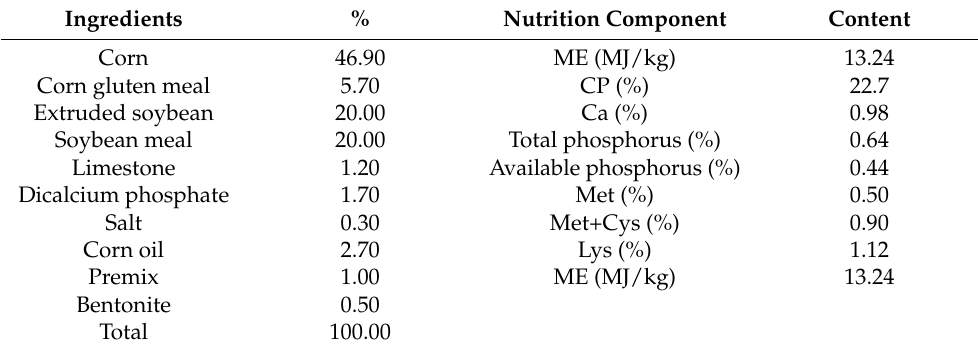
Table 1. Ingredients and nutrient composition of the basal diet (% as-fed